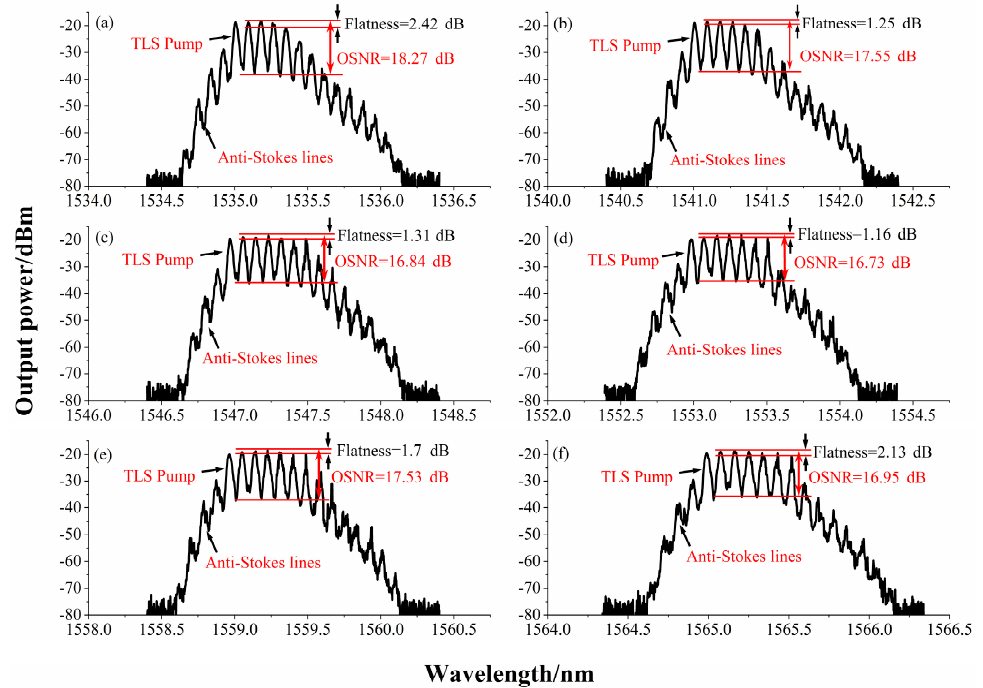
Figure 5. Output spectra of different TLS wavelengths. ( a ) TLS wavelength = 1532 nm, ( b ) TLS wave- length = 1542.5 nm, ( c ) TLS wavelength = 1547 nm, ( d ) TLS wavelength = 1553 nm, ( e ) TLS wave- length = 1559 nm, ( f ) TLS wavelength = 1565 nm.